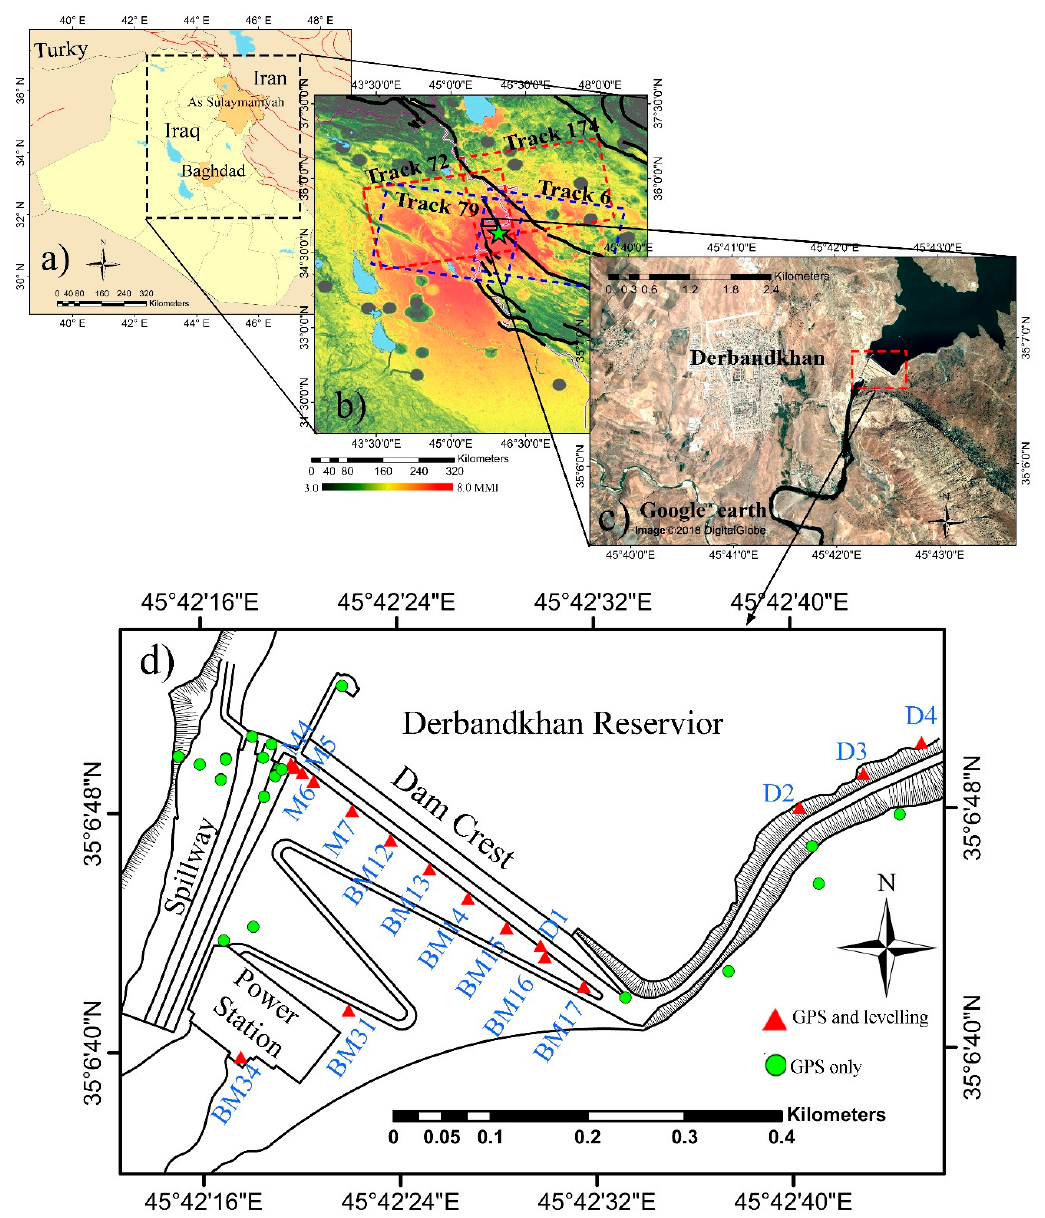
Figure 1. The geological settings of the Darbandikhan dam. ( a ) Regional map of Iraq, ( b ) shaking intensity map of the earthquake with geological faults indicated by black lines [4]. The colour bar refers to the shaking intensity magnitude, the green star indicates the epicenter [4], ( c ) optical image showing the location of the Darbandikhan dam [5], ( d ) the instrumentation network and the main features of the Darbandikhan dam. Triangles refer to the pillars observed with GPS, and levelling while circles indicate the pillars observed with GPS only.